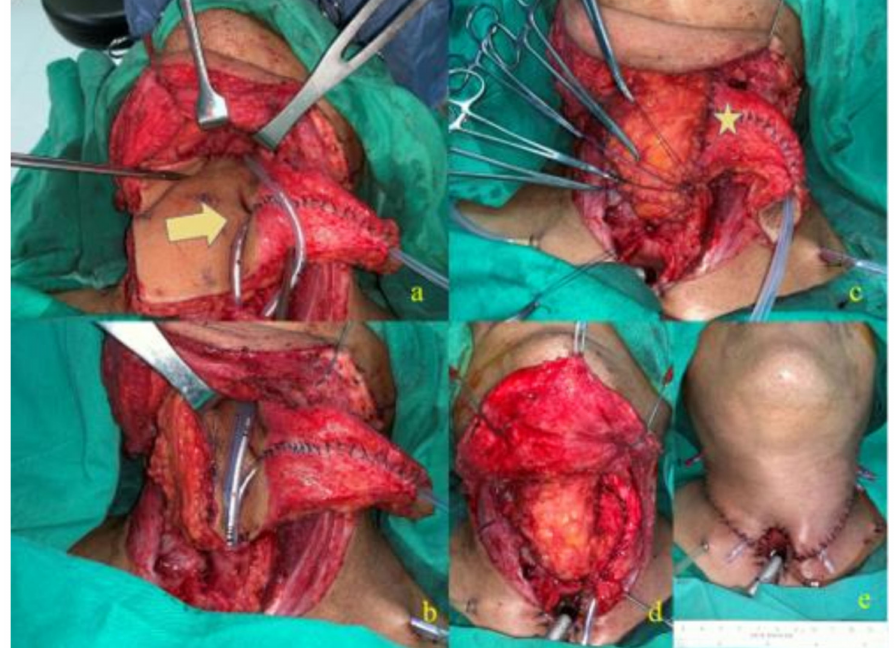
Figure 2. Demonstration of the inset of the J-flap: ( a ) inset of the proximal esophagus, and internal orifice of the phonation tube (arrow); ( b ) inset of the distal esophagus; ( c ) inset of the esophageal tube, and proximal portion of the phonation tube (star); ( d ) inset of the distal orifice of the phonation tube to the tracheostoma; ( e ) inset of the cervical flap, and completed